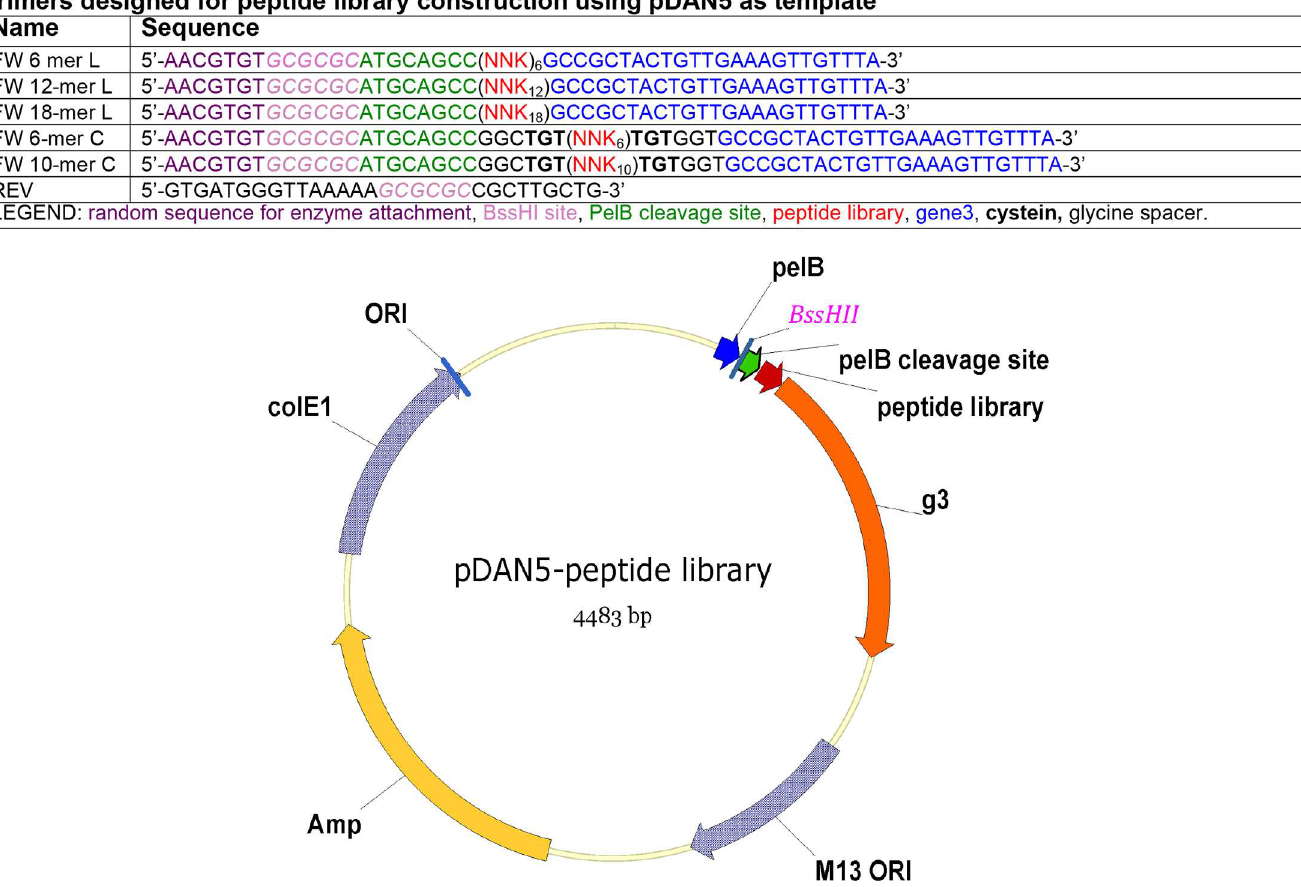
Fig 3. Vector map and primers used for libraryconstruction. The forward primers(FW)incorporated the different sets of randompeptidesequences. The randomsequencesare coded by NNK, where N = A,T,C, or G and K = G or T.